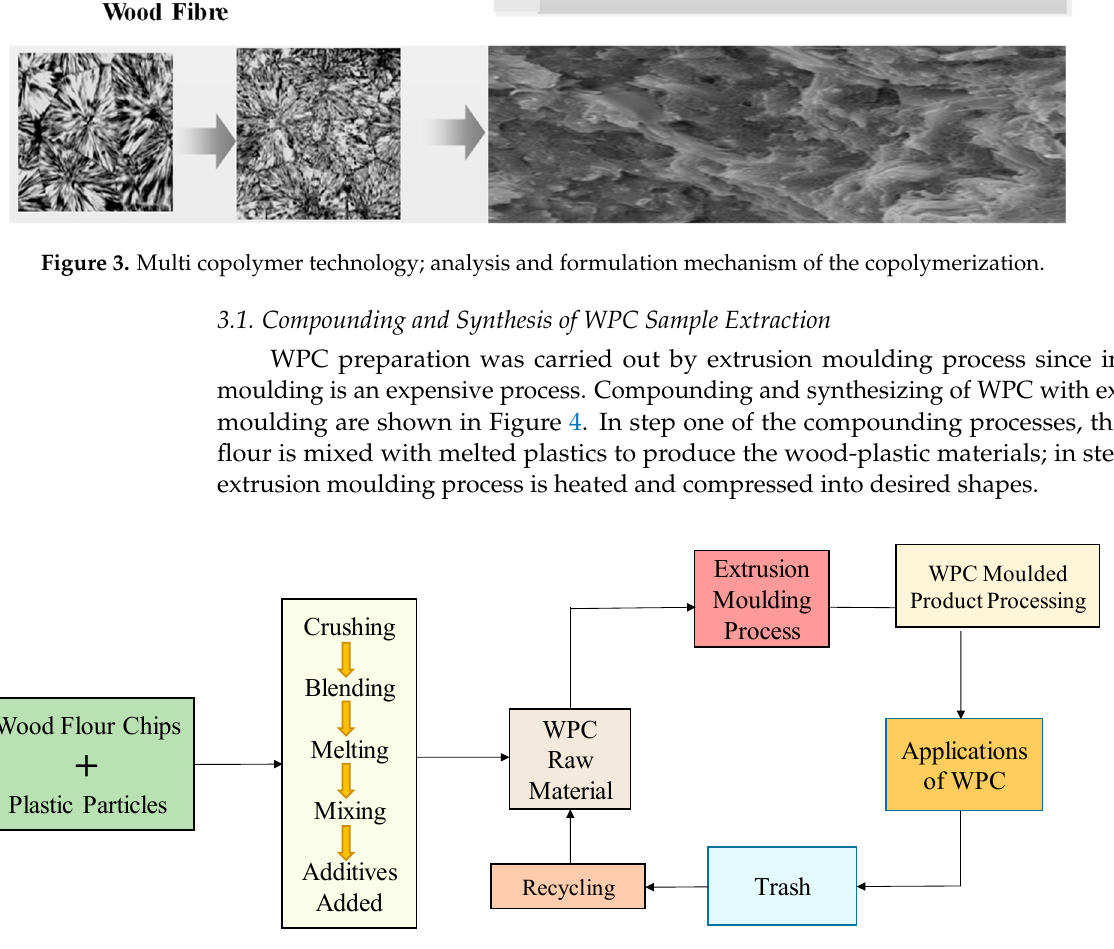
Figure 4. Compounding and Synthesizing of WPC with Extrusion Moulding.